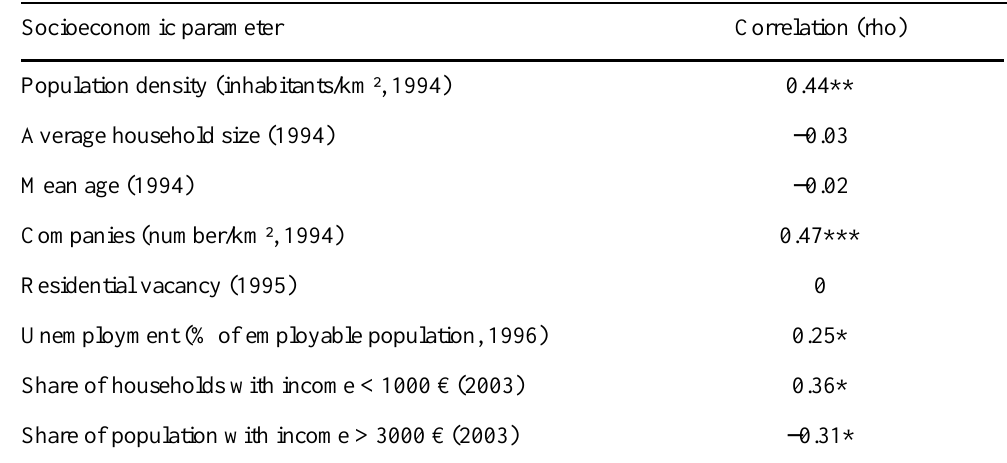
Table 2. Spearman rank correlation between socioeconomic indicators and the percentage of human population in neighborhoods with below-average neighborhood bird diversity at the municipal district